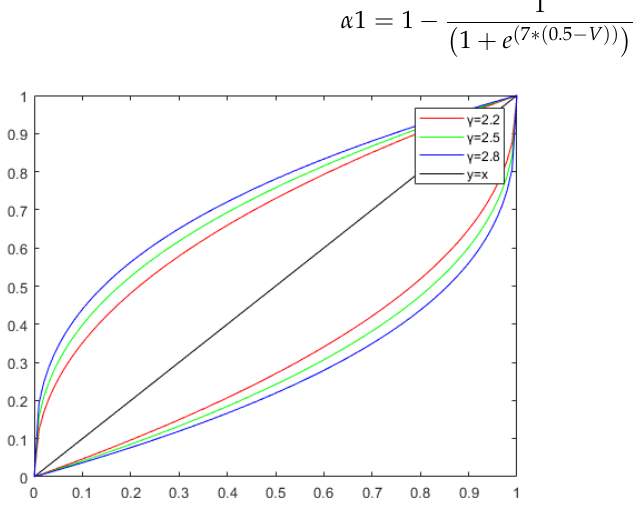
Figure 4. The function curves for γ values of 2.2, 2.5, and 2.8. The curve above y = x is V1 transformed with γ , and the curve below y = x is V2 transformed with γ . The red curve represents a γ value of 2.2, the green curve represents a γ value of 2.5, and the blue curve represents a γ value of 2.8.